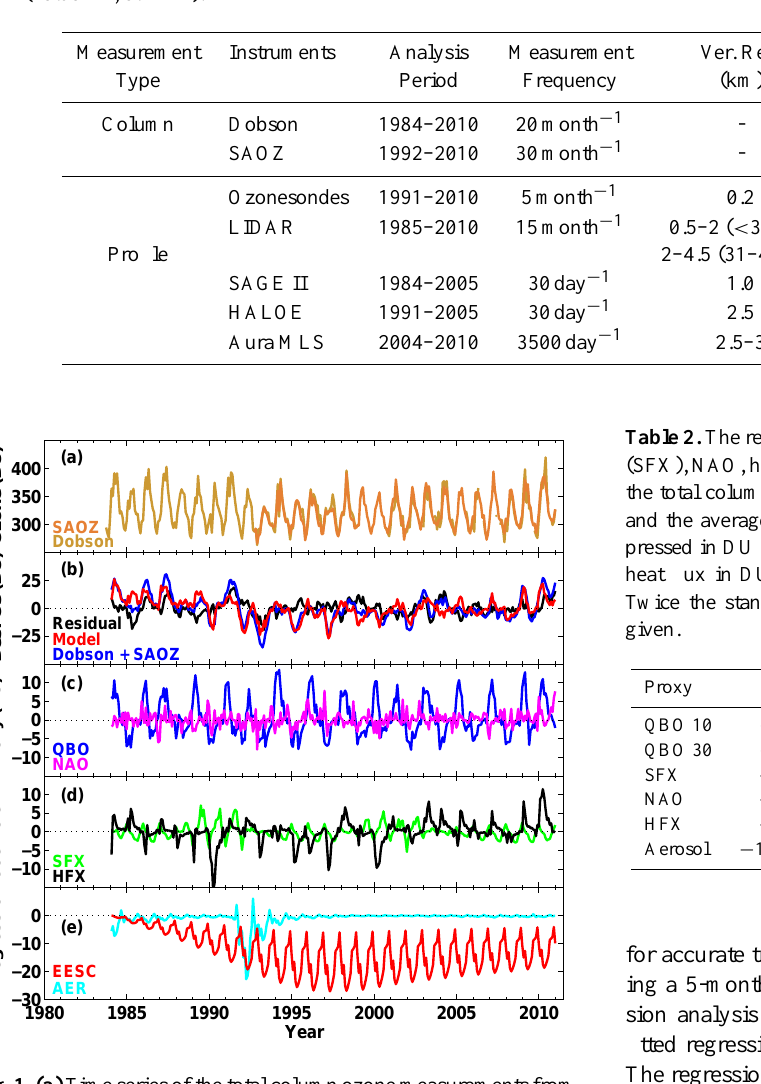
Fig. 1. (a) Time series of the total column ozone measurements from the Dobson and SAOZ spectrometers; (b) monthly mean deseason- alised ozone, the EESC-based model and the residual; (c) ozone- fitted signals of proxies QBO and NAO; (d) solar flux (SFX) and